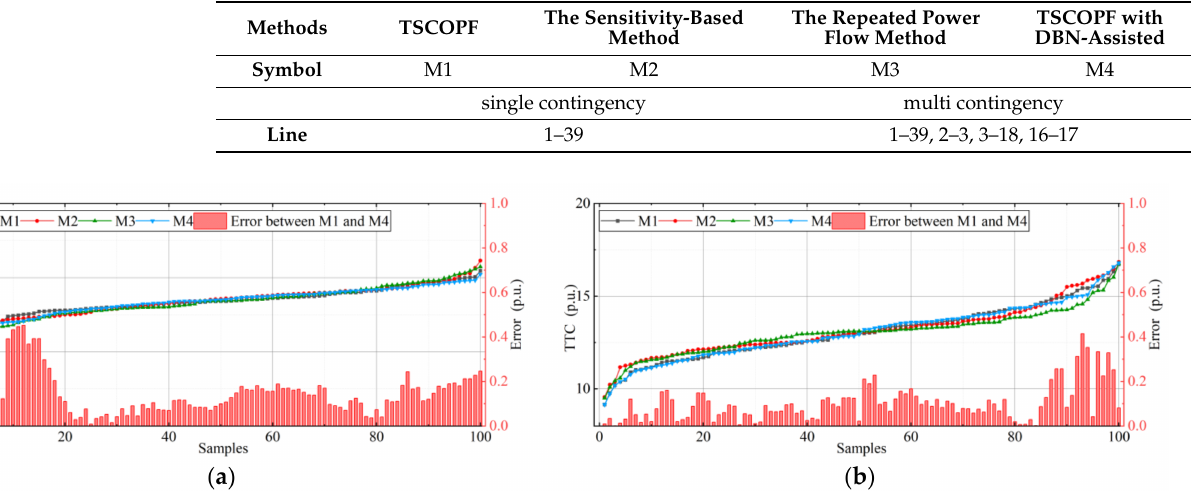
Figure 4. The results of TTC calculation under four different methods: ( a ) Single contingency; ( b ) Multi